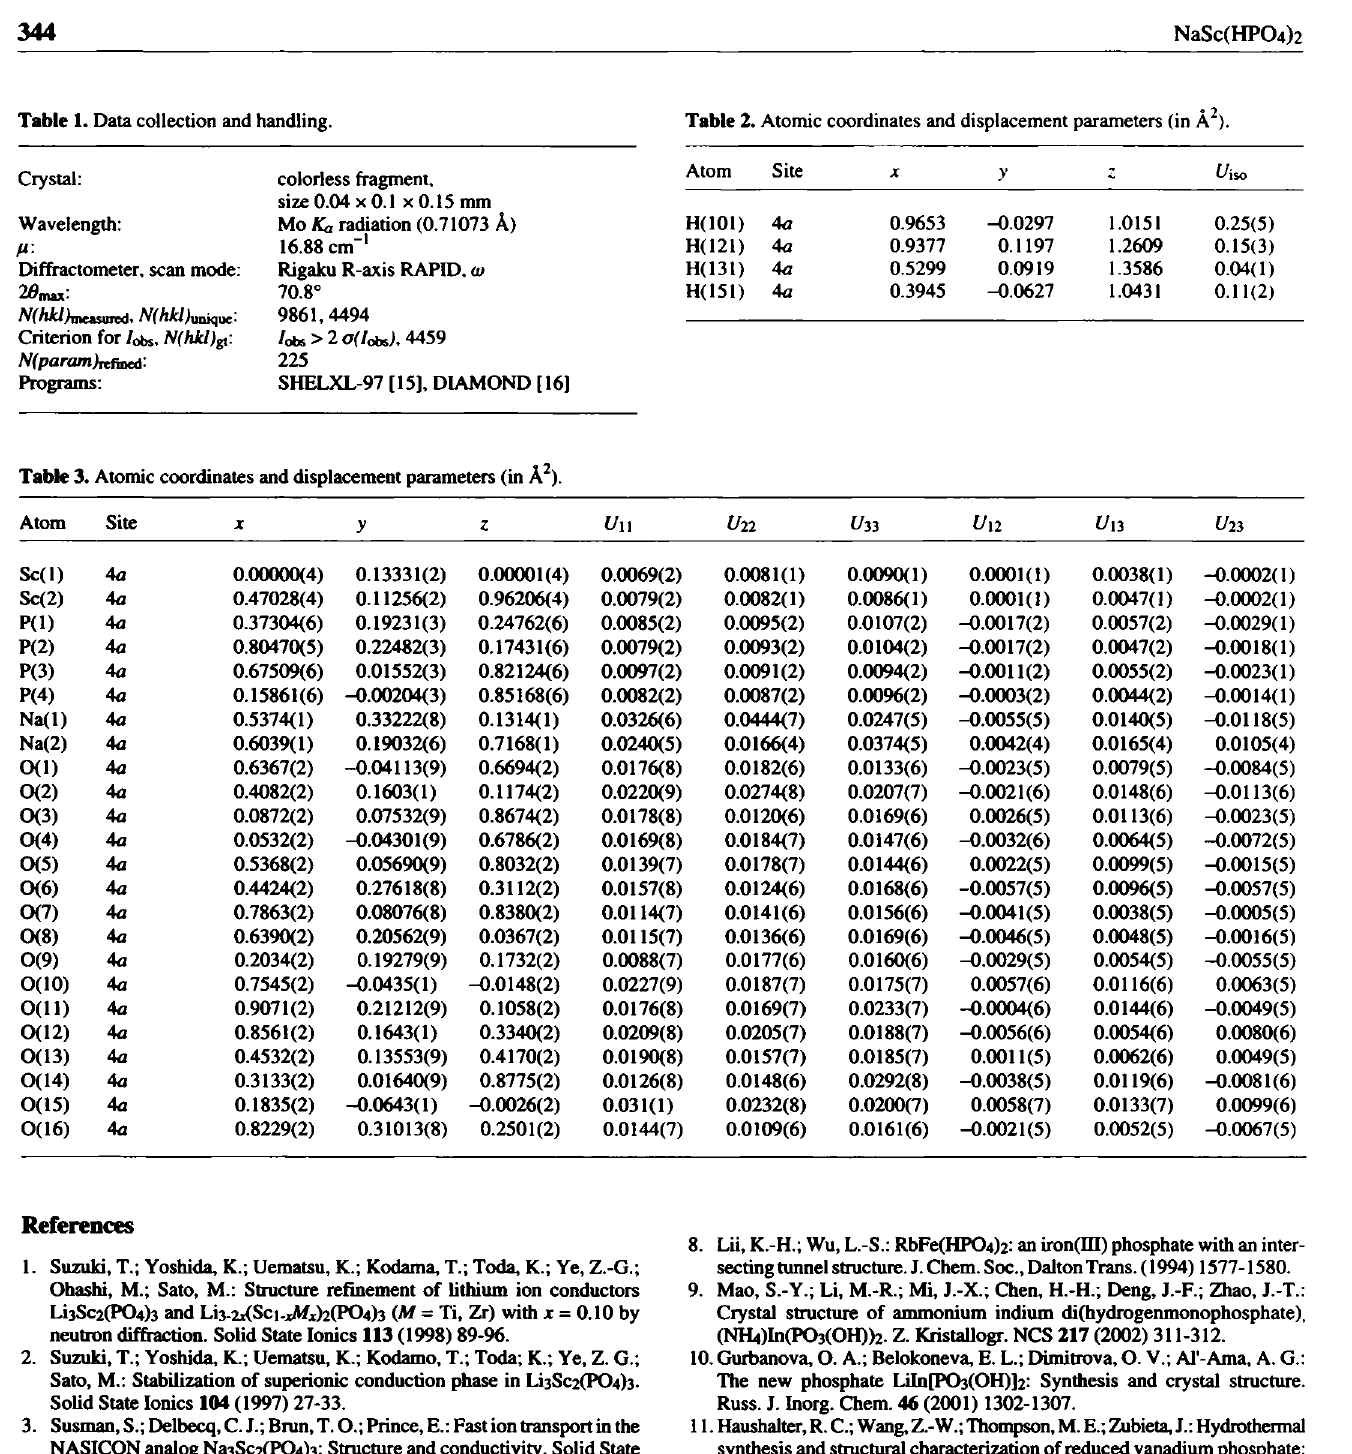
Table 1. Data collection and handling. Table 2. Atomic coordinates and displacement parameters (in Â ).